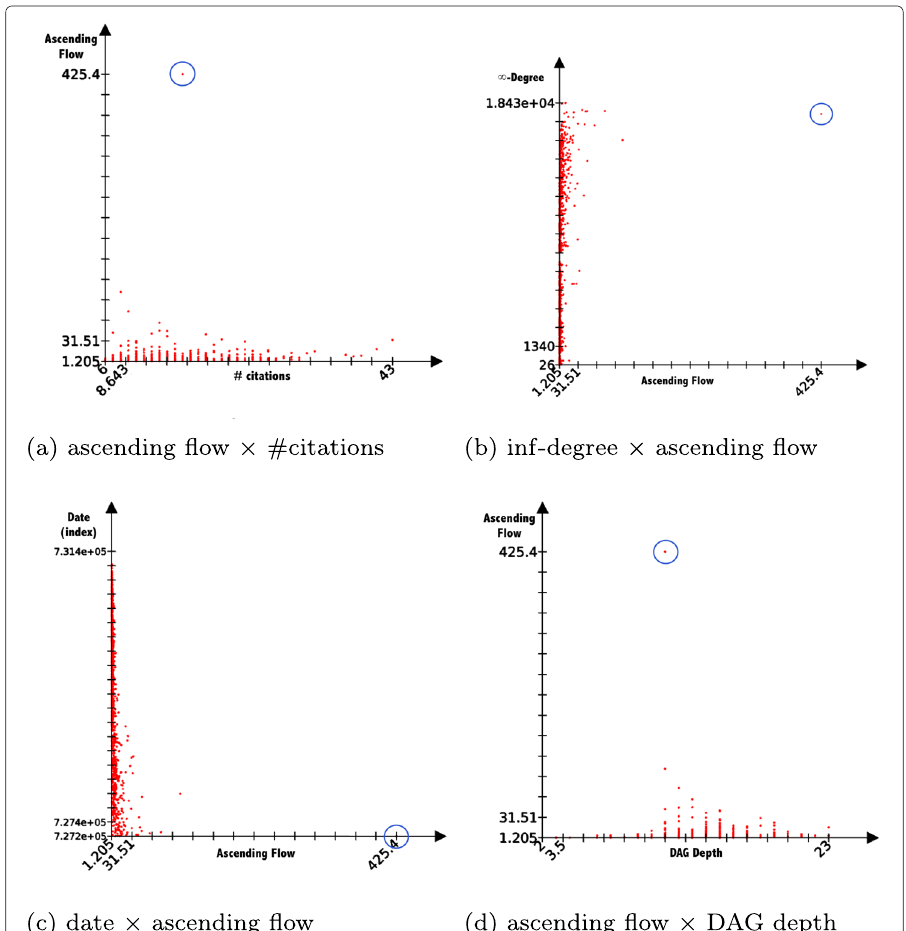
Fig. 6 Comparative distributions of the ascending flow against: a 1-degree (i.e. number of citations b ∞ -degree (i.e. number total of generated publications), c date of publication, and d in blue the outlier detected by the ascending